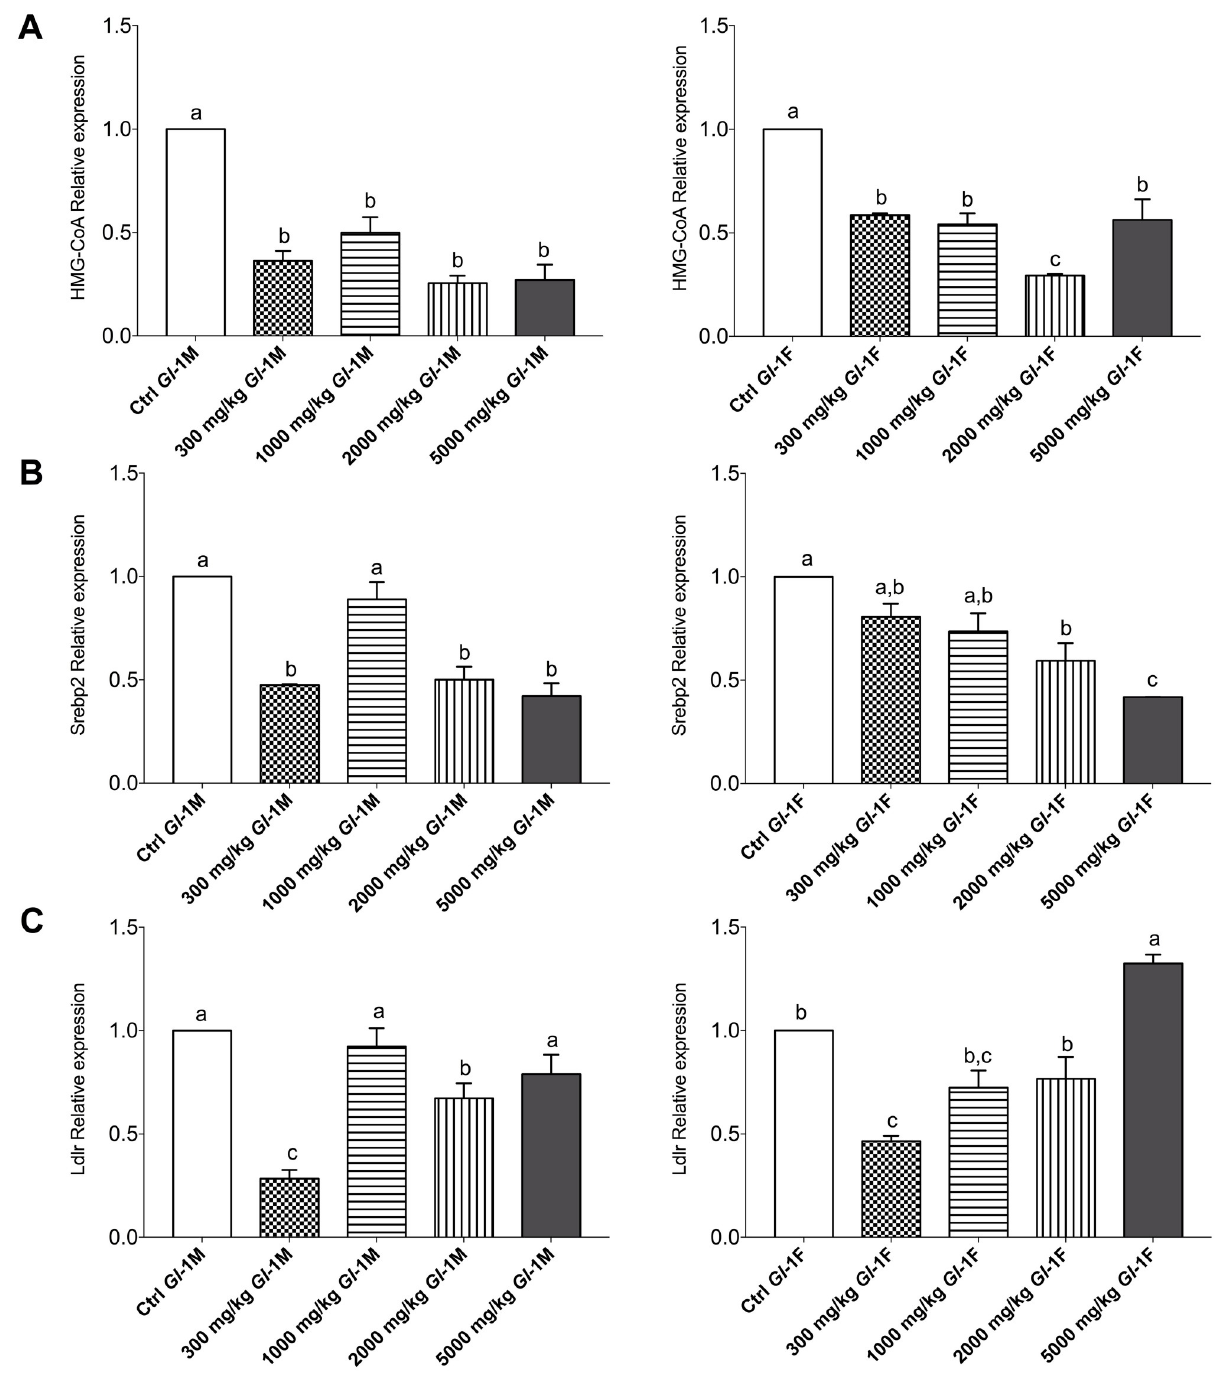
Fig 9. Expression of genes linked to cholesterol metabolism in liver tissue from male (M) or female (F) Wistar rats fed with the control diet (Ctrl) and different doses of the standardized Gl -1 extract of Ganoderma lucidum for 14 experimental days. A: HMG-CoA. B: Srebp2. C: Ldlr. Data are presented as mean ± SEM per experimental group. Different letters on a column indicate significant differences, p < 0.05. Values ( p ) correspond to one-way ANOVA from Tukey’s multiple comparison test. The dose administered per experimental group is described in the materials and methods